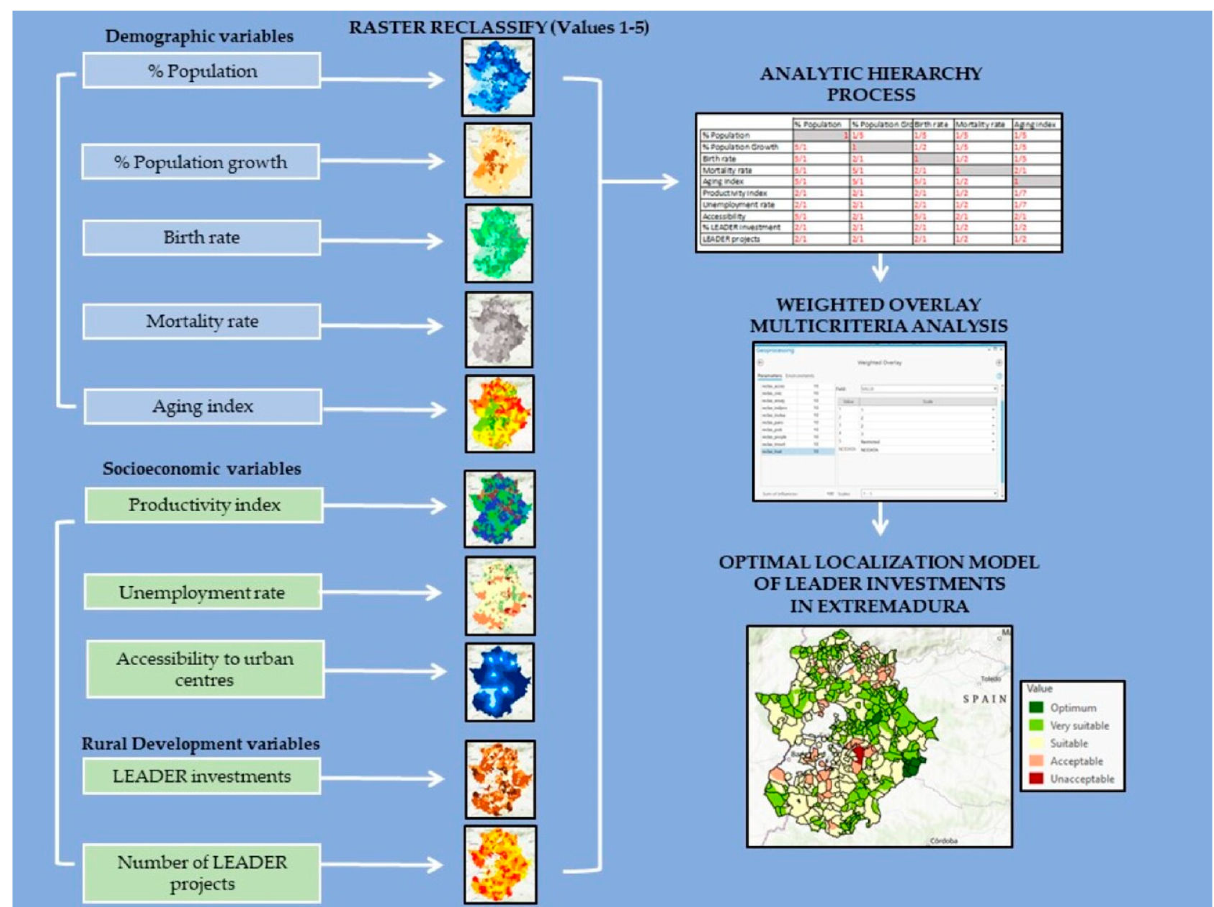
Figure 5. Optimal localization model of LEADER investments in Extremadura. Source: Authors.